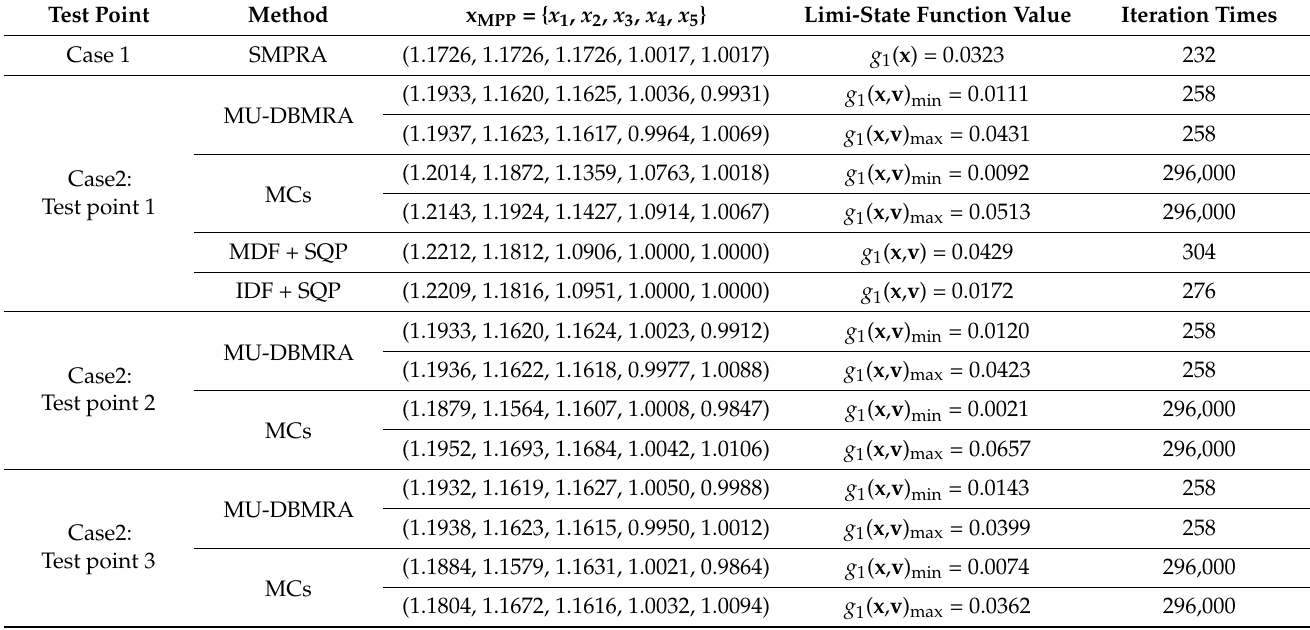
Table 1. Reliability analysis results of the numerical